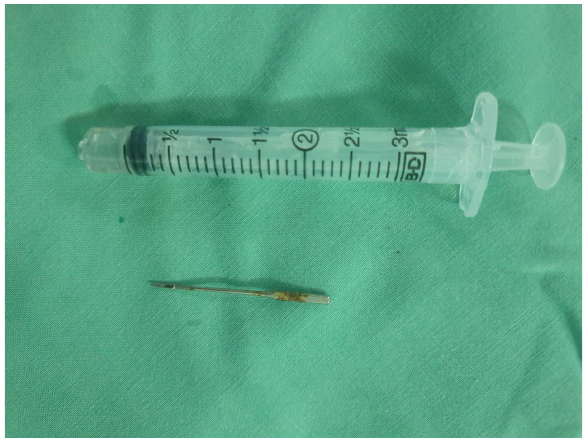
Figure 3: Sewing needle retrieved from the urethra